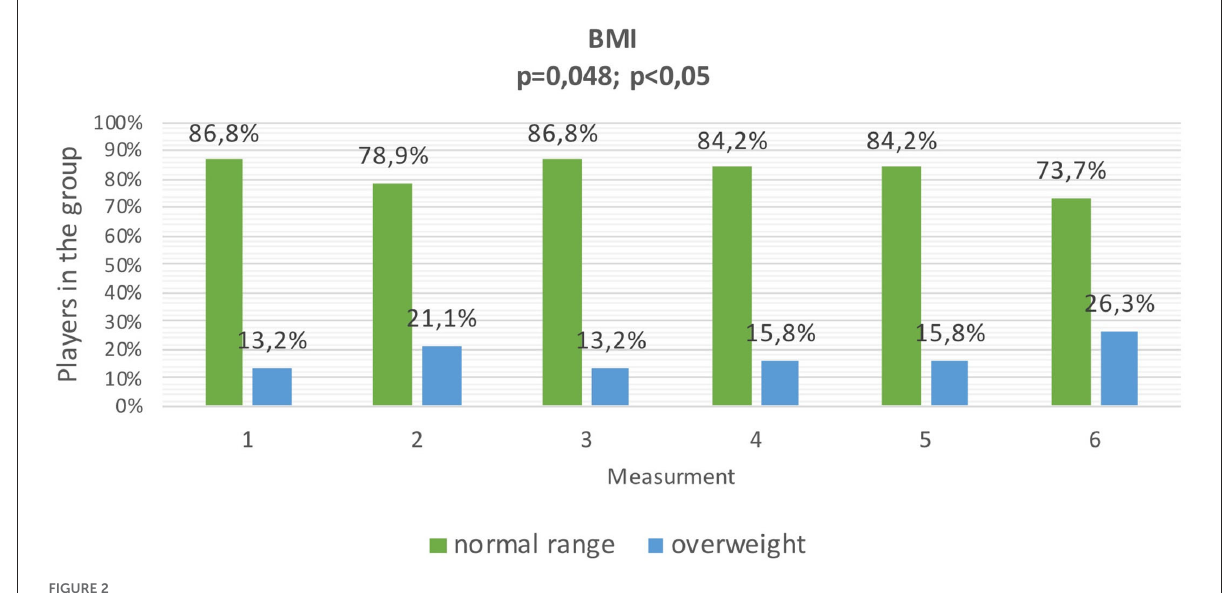
FIGURE2 Change in nutritional status of football players assessed by BMI ( n = 38).